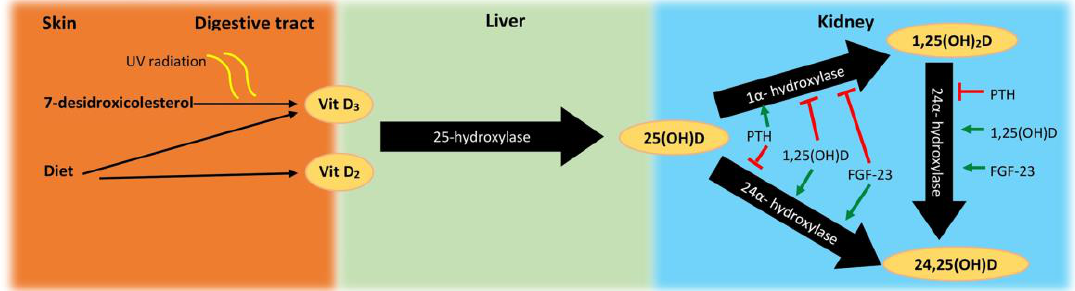
Figure 2. Schematic representation of vitamin D metabolism. UV, ultraviolet; Vit D 2 , vitamin D 2 ; VitD 3 , vitamin D 3 ; PTH, parathyroid hormone; FGF-23, fibroblast growth factor 23.